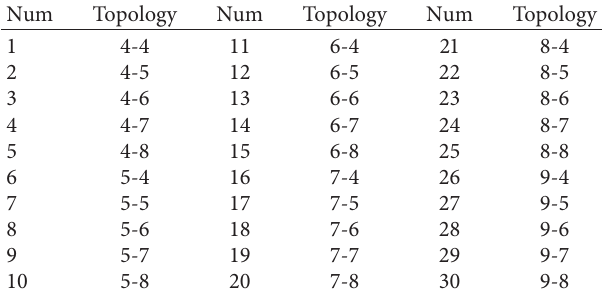
Table 2: Trained artificial neural network architectures.